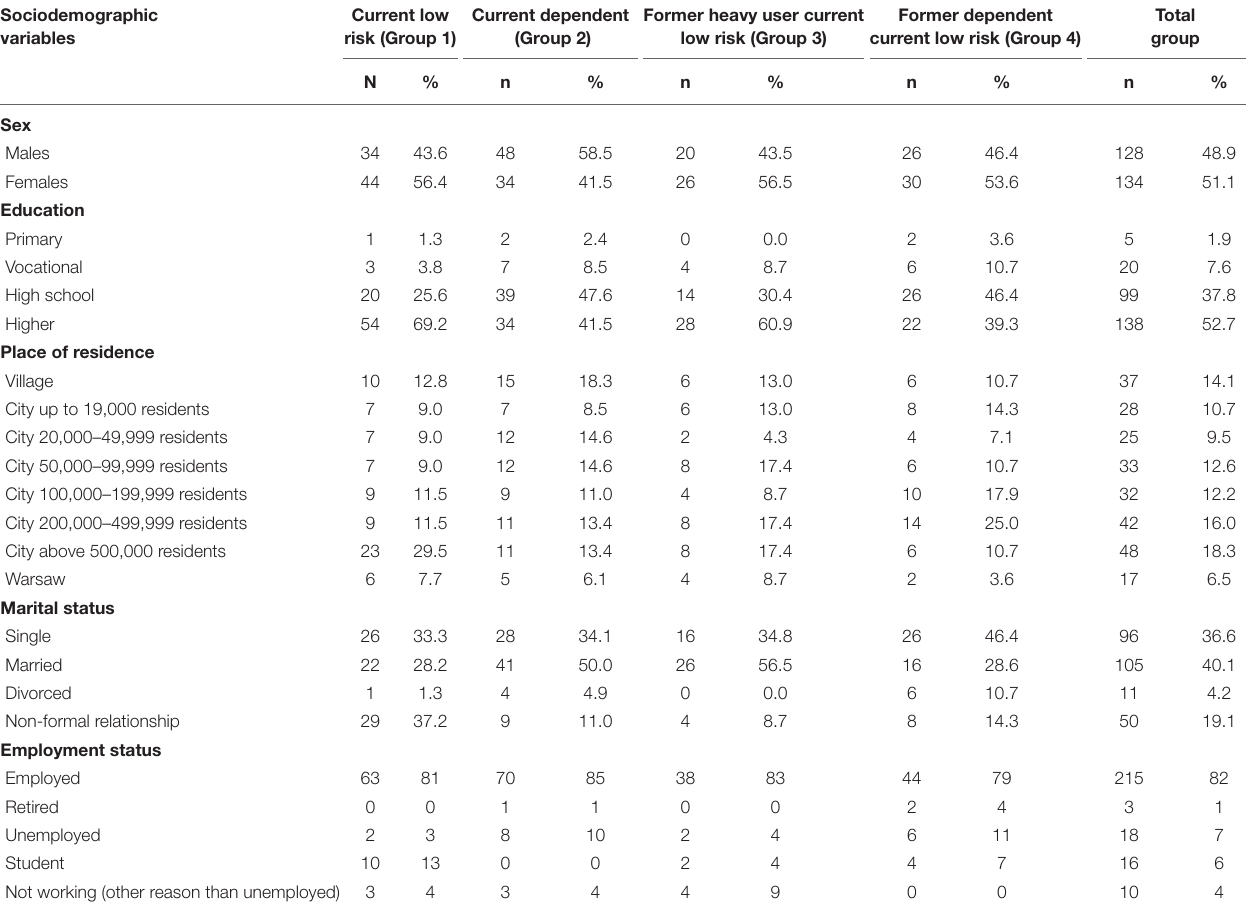
TABLE 1 | Sociodemographic variables in the total sample and the four investigated groups.